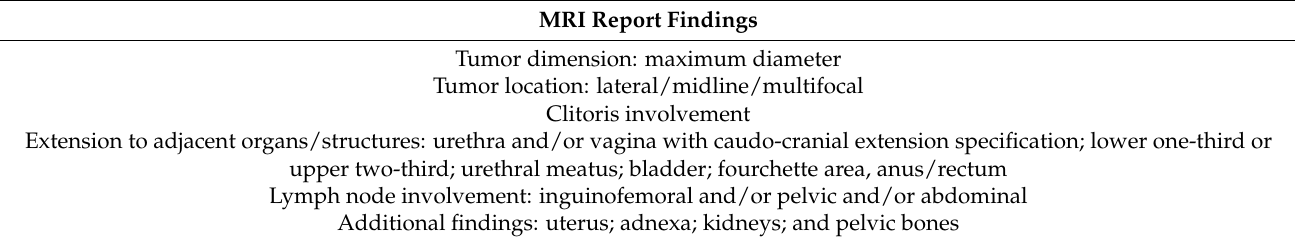
Table 2. MRI-focused report for locally advanced vulvar cancer